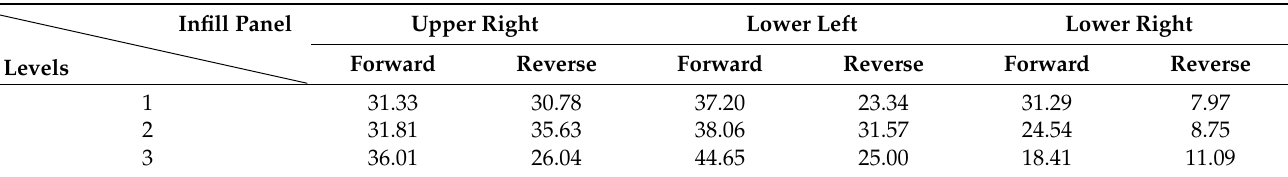
Figure 22. Variation of the inclination angle of the first principal stress in the wall panel. Table 7. The inclination angle of the first principal stress at each part of wall panel under the forward and reverse loading test (units: ◦